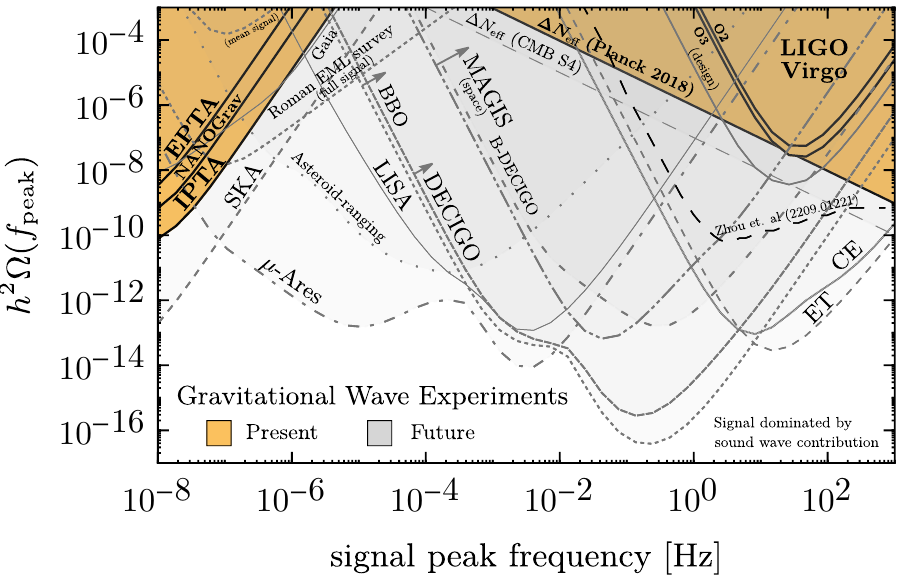
Figure 12 . Current and future prospects for detecting a phase transition signal for a given peak frequency and amplitude. Here we use the resulting signal from BP1 in table 1, shifting only the peak amplitude and frequency. Using the curves from table 2 we show the sensitivity based on an SNR approach using the thresholds ρ th for each given